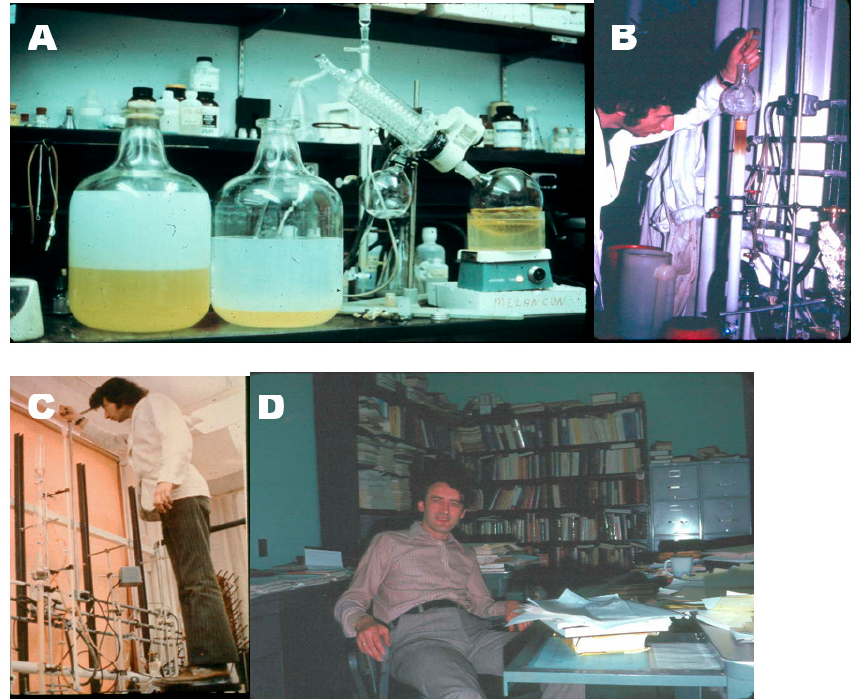
Figure 10. ( A ) Lipid extraction of 1450 chicken intestines. The yellow chloroform organic phase that contained the active metabolite was being dried down under vacuum in preparation for its first chromatography on a Shephadex LH-20 column ( B ) The dried down lipid extract from the intestines was first chromatographed on a Shephadex LH-20 column and eluted with a mixture of 65% chloroform in hexane. ( C ) In one of the final chromatographies, the semi-purified active vitamin D 3 metabolite was dissolved in methanol and chromatographed on a Shephadex LH-20 column prepared in methanol. ( D ) Dr. Heinrich Schnoes in his office. Holick copyright 2023. Reproduced with permission.